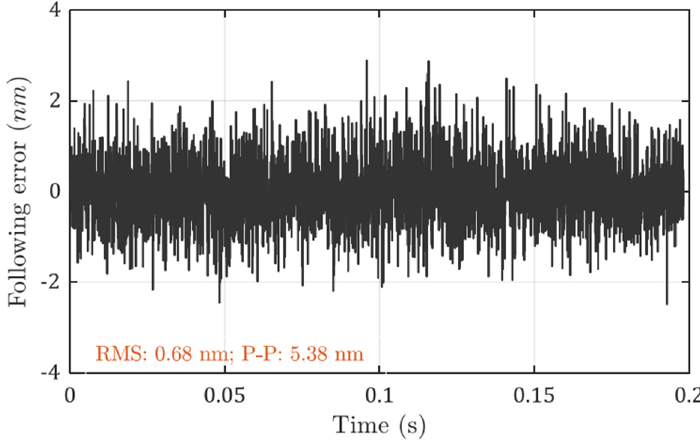
Figure 7. Measured following error with optimal controller at a bandwidth of 1.1 kHz.